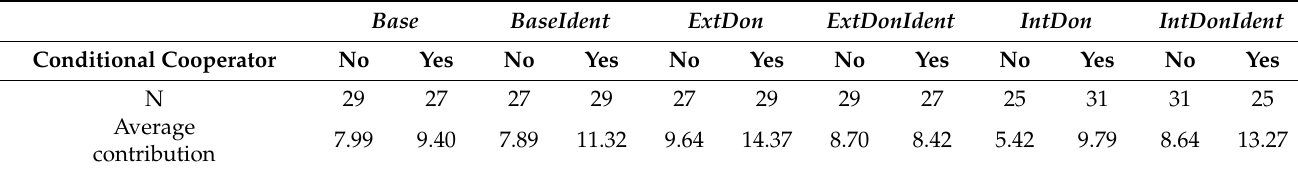
Table A4. Median split of conditional